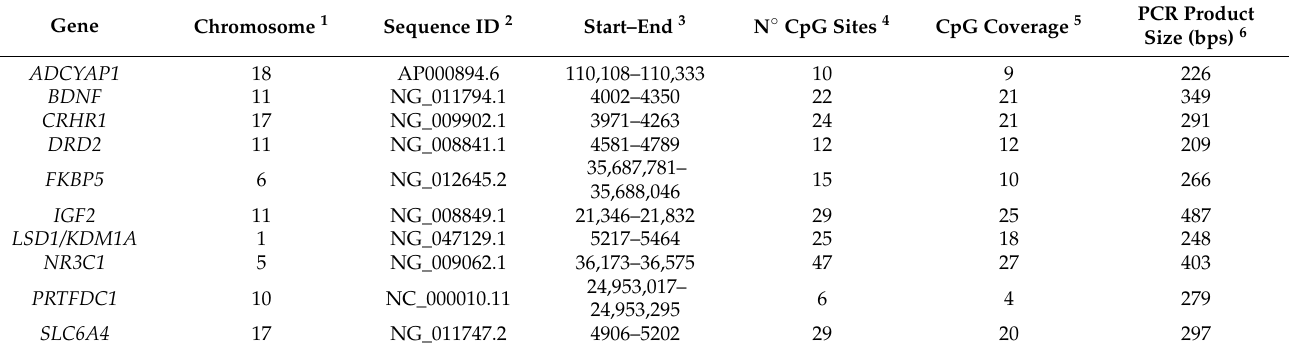
Table 1. 1 chromosome location, 2 reference sequences, 3 genomic positions, 4 CpG sites within the investigated region, 5 CpG sites quantified by the EpiTYPER software, and 6 amplicon lengths of the investigated